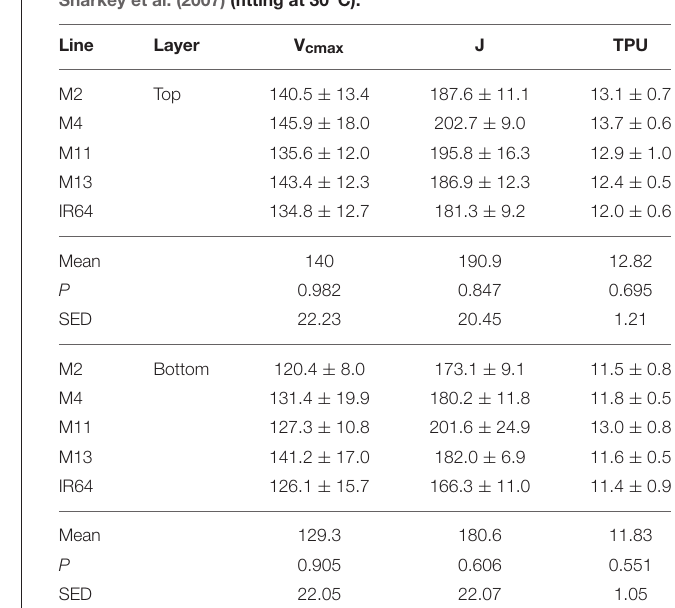
TABLE 2 | Parameters taken from ACi curve fitting at GS1 (45 DAT) using Sharkey et al. (2007) (fitting at 30 ◦ C).